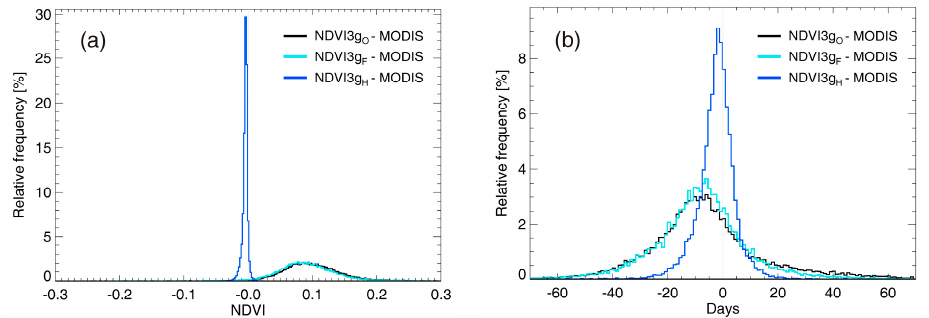
Figure 4. Frequency distribution of ( a ) maximum NDVI bias and ( b ) the bias of the maximum NDVI timing during the 2000–2013 time period for NDVI3g O (black), NDVI3g F (light blue) and NDVI3g H (dark blue) relative to NDVI MODIS . Positive NDVI bias means higher maximum NDVI for NDVI3g, while the positive bias of peak NDVI dates means earlier maximum NDVI for MODIS (n = 20191).